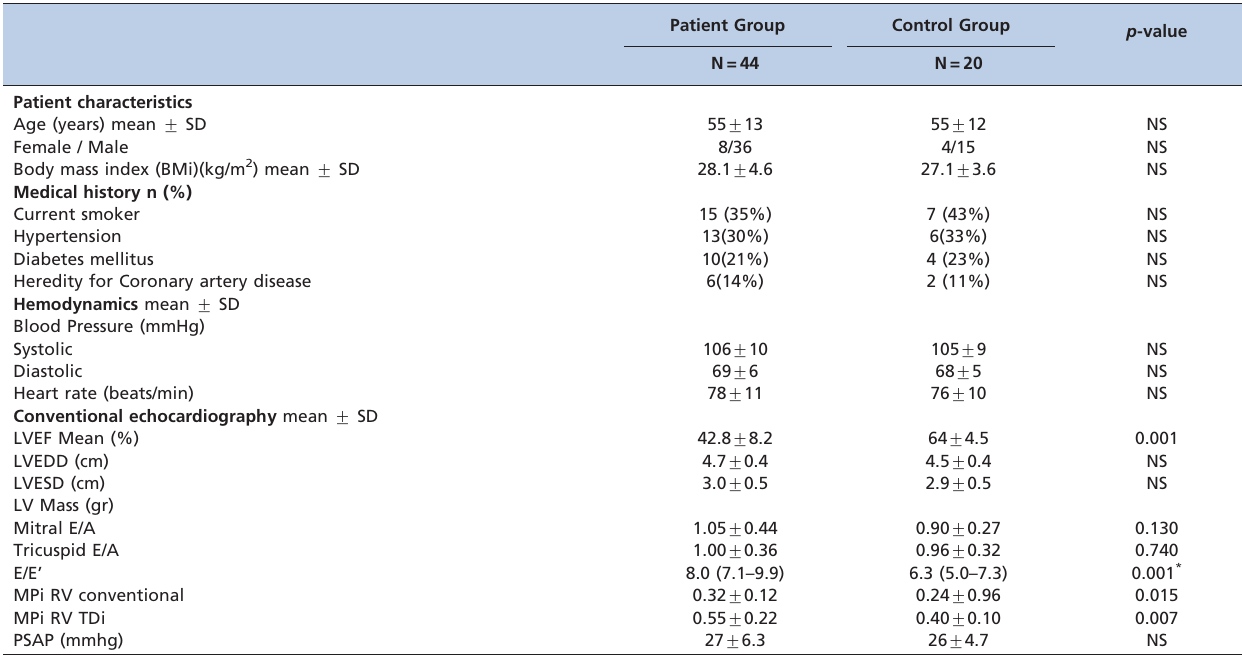
Table 1 - Baseline patient